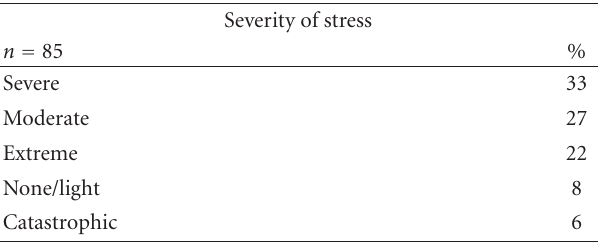
Table 5: The severity of stress generated by stressful life events (axis 4,